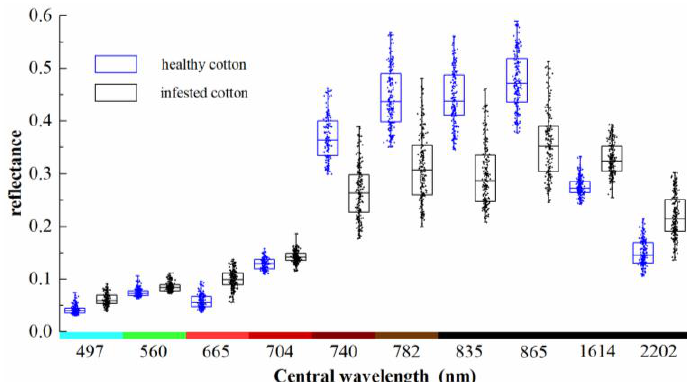
Figure 4. Box-scatterplots of reflectance of healthy cotton and root rot-infested cotton.